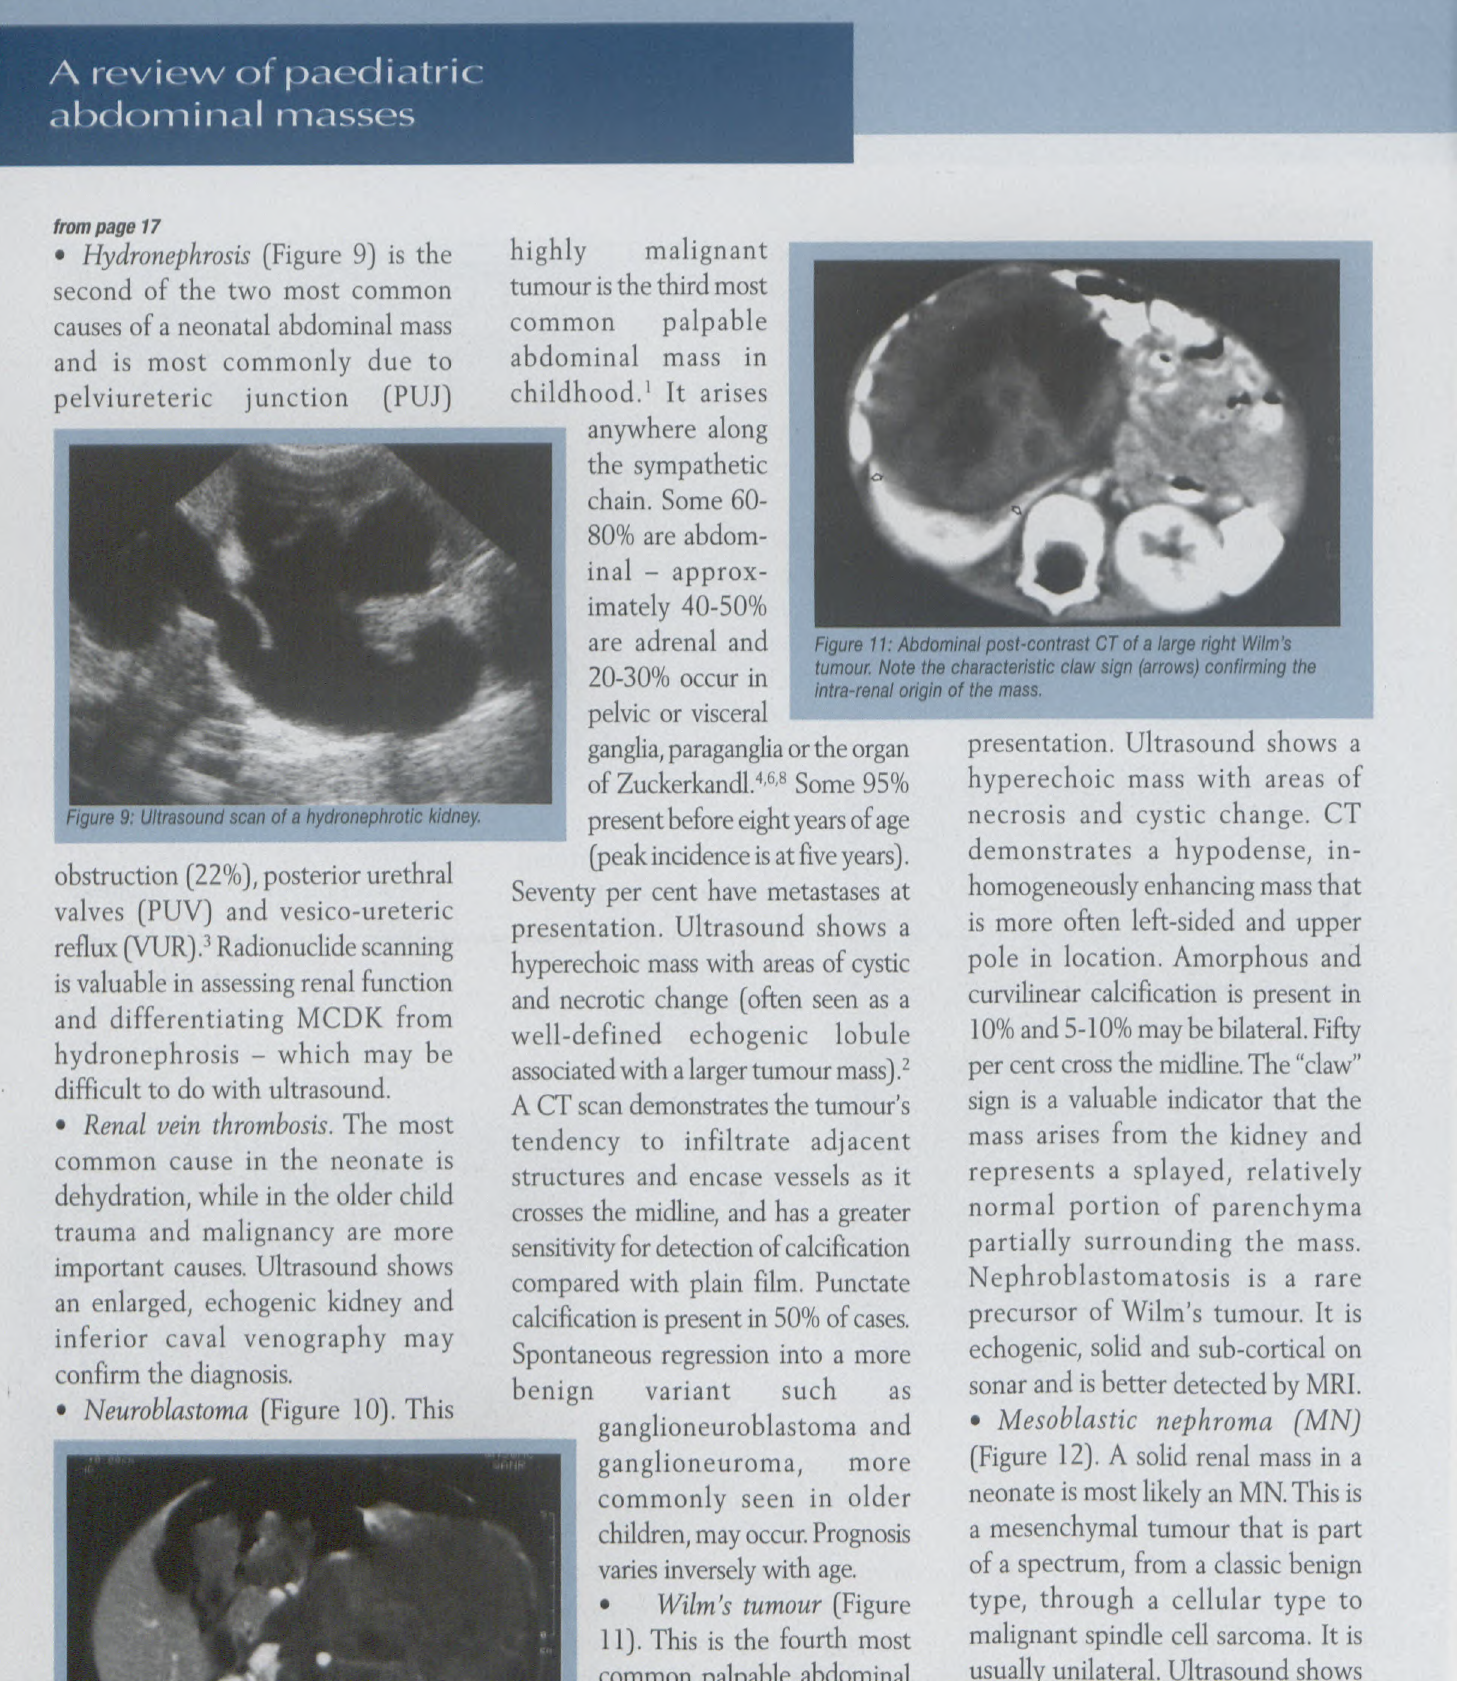
Figure10:Contrasted abdominal CT There is an irregular mass antenor to the left kidney, which crosses the midline and encases the aorta (arrow). Thefeatures are typical of a